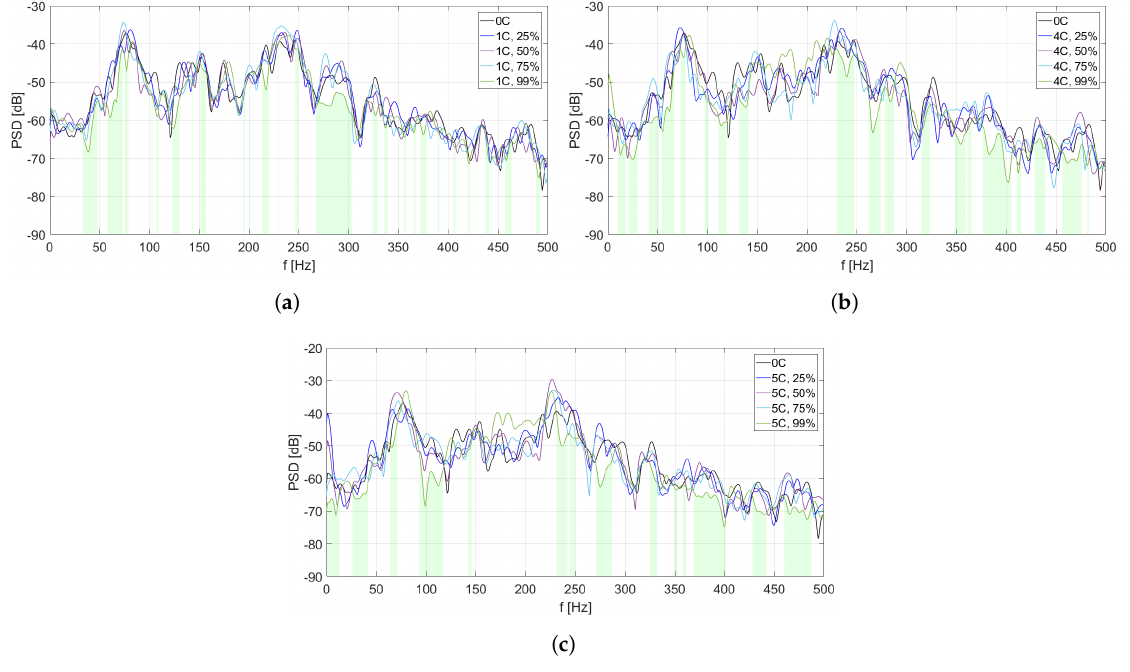
Figure 7. PSD estimates of MFC2 input signals: ( a ) scenario of one coupling activated, ( b ) scenario of four couplings activated, ( c ) scenario of five couplings